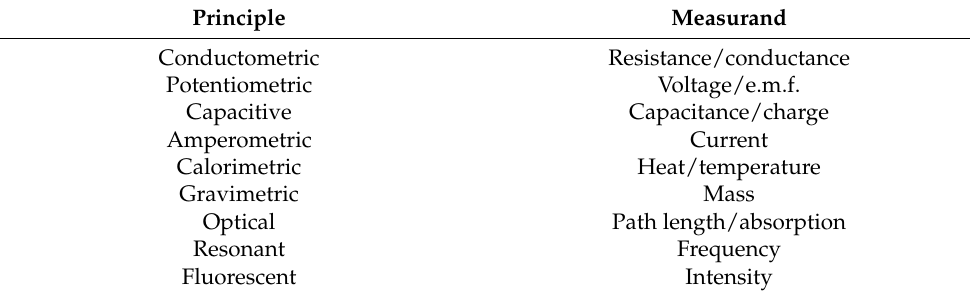
Table 2. Principles and measurands of some typical